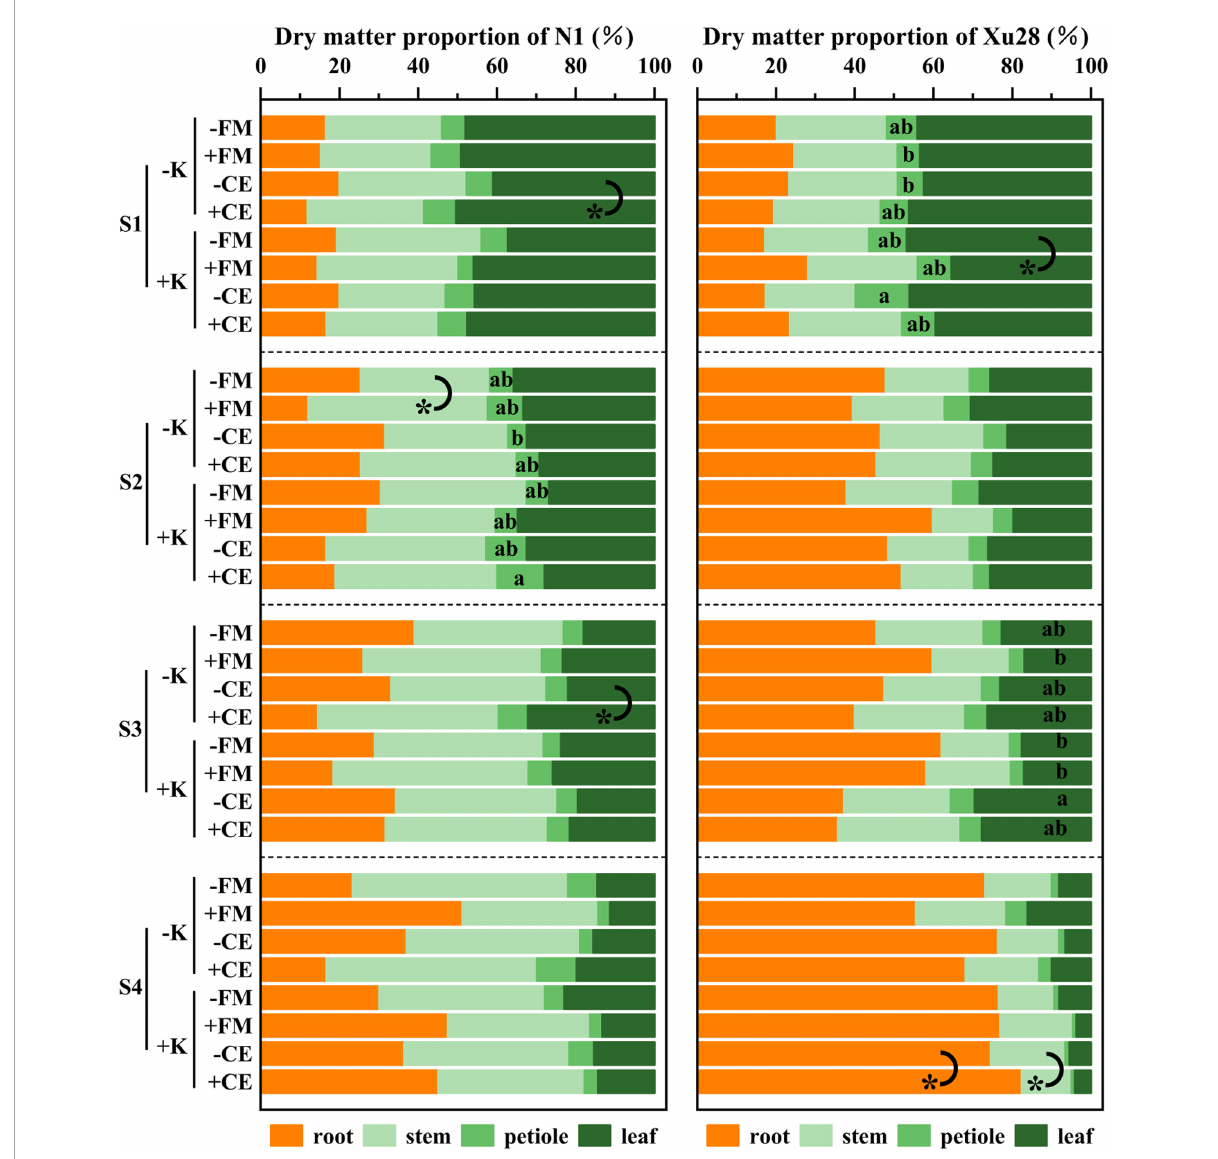
FIGURE6 The effects of potassium application and arbuscular mycorrhizal fungi inoculation on dry matter proportion of different organs of sweet potato. For each growth stage, different lowercase letters indicate significant differences between different groups ( P < 0.05). For different groups, asterisks denote significant differences after arbuscular mycorrhizal fungi (AMF) inoculation ( t -test; * P <